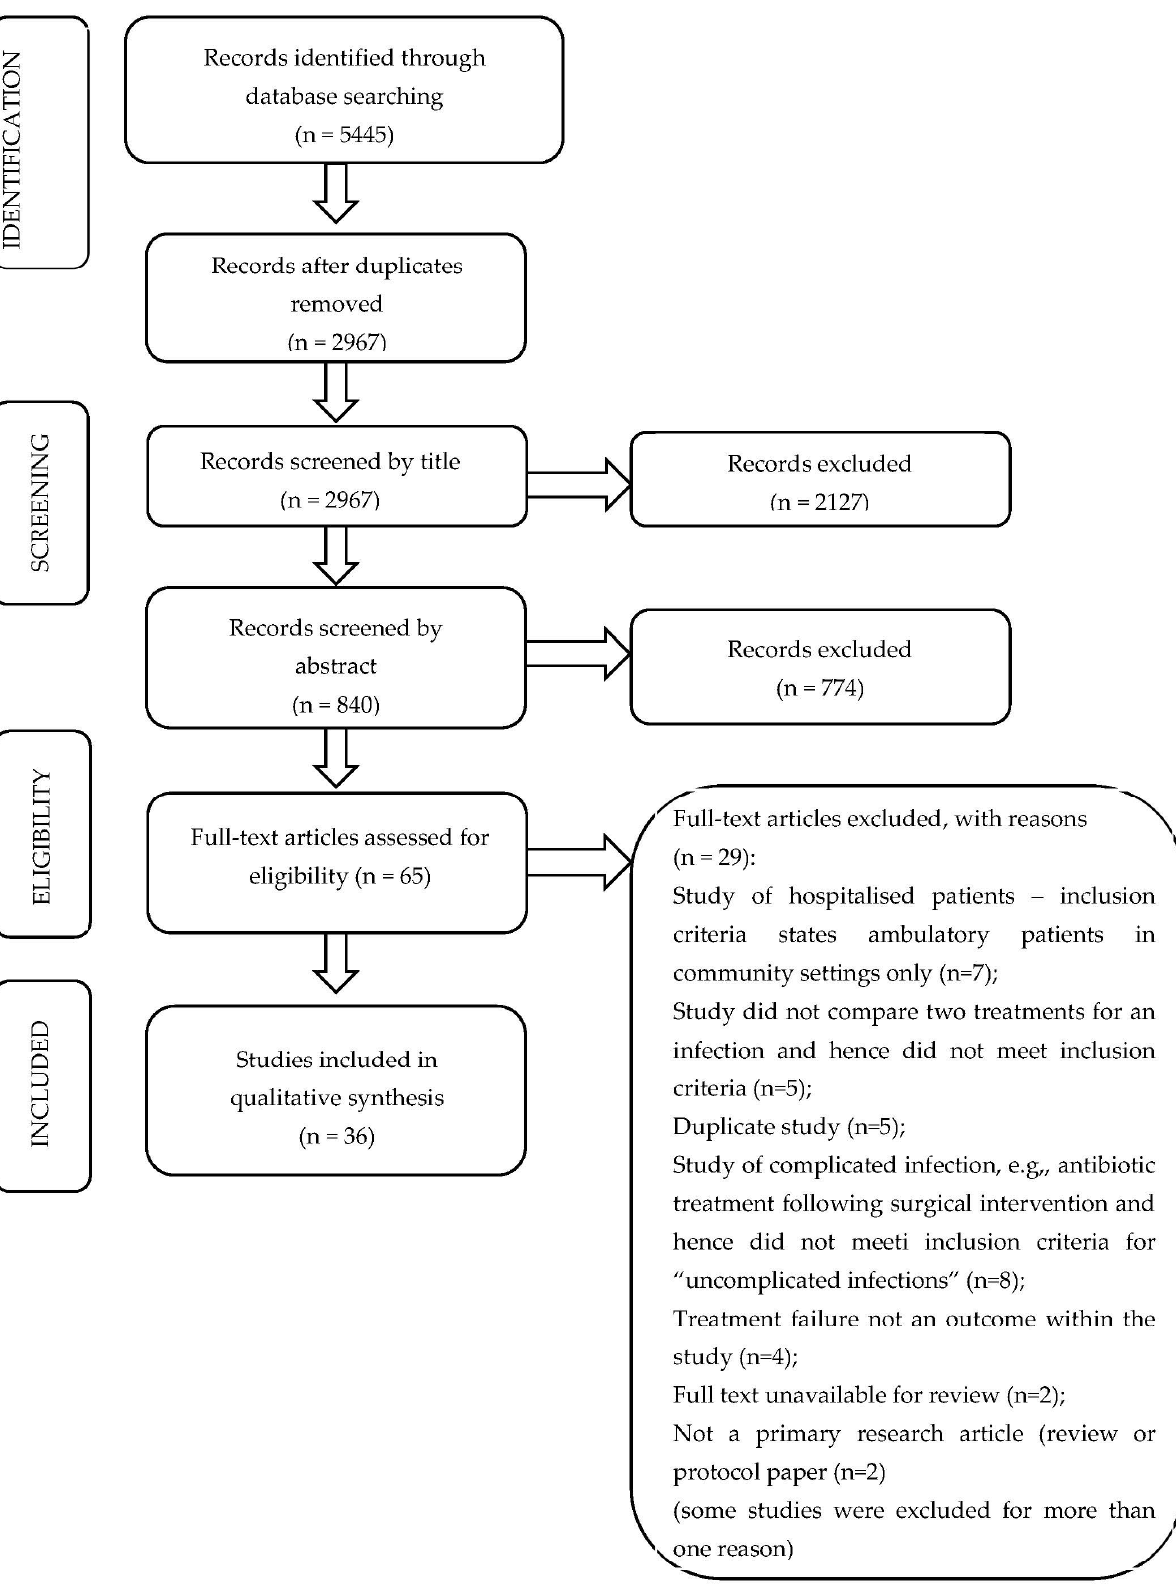
Figure 1. PRISMA diagram of included and excluded studies.